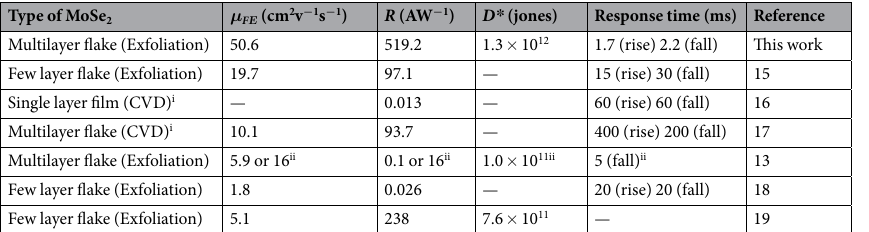
Table 1. Performance of MoSe 2 phototransistors measured at P in = 10–100 mWcm − 2 . i Chemical vapor deposition. ii With HfO 2